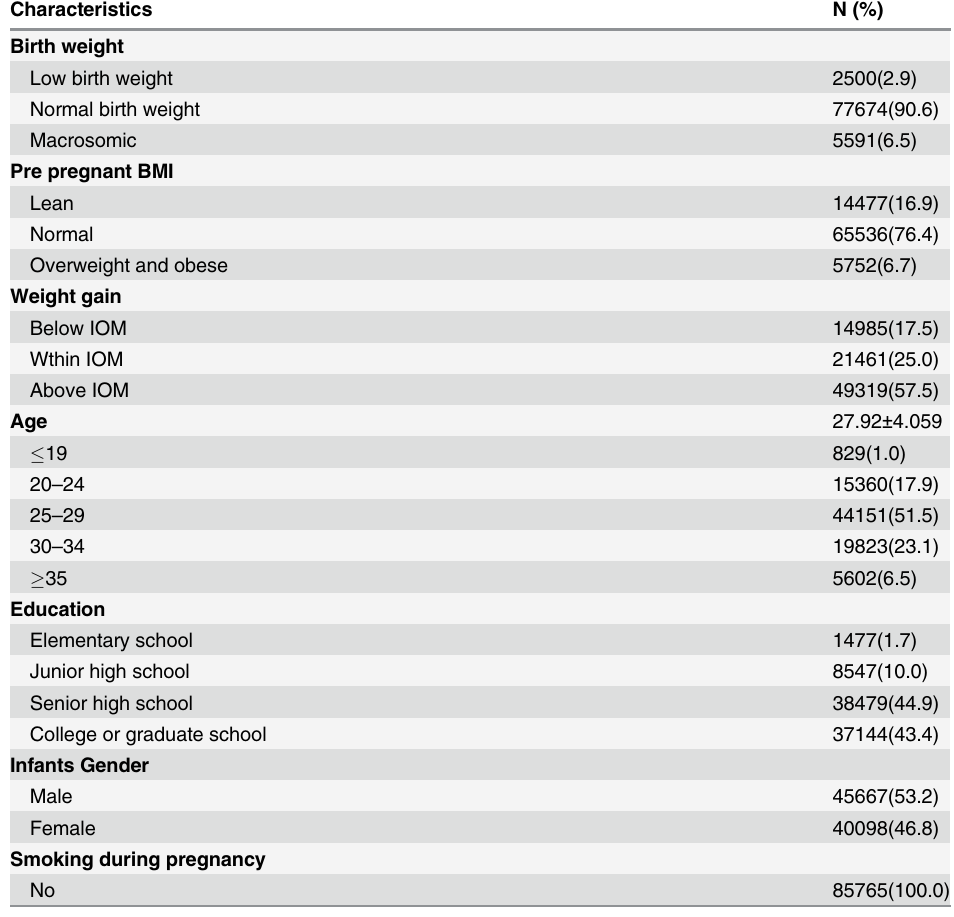
Table 3. Characteristics of women and